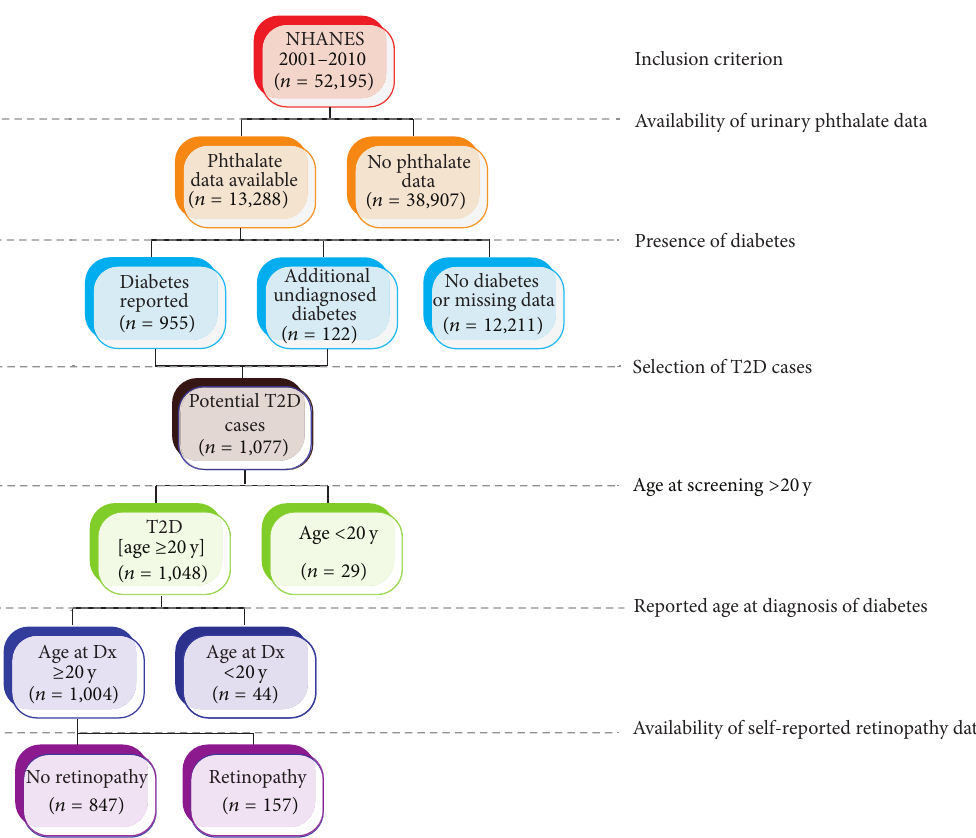
Figure 1: Selection of study subjects. This chart shows how the final number of 1,004 participants included in this study was selected. On the right side are shown the inclusion criteria that correspond to the selection of